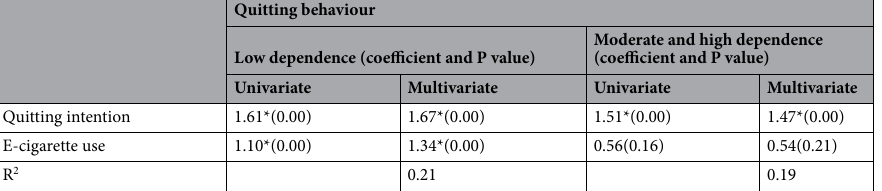
Table 4. Logistic regression models of the quitting behaviour regressed on quitting intention and e-cigarette use by tobacco dependence. We controlled for sex, education attainment, alcohol drinking in all the models. *p <